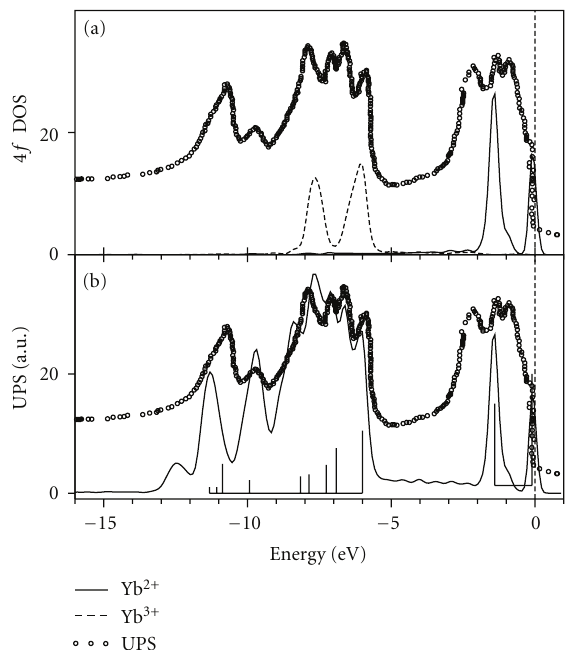
Figure 57: (a) The calculated 4 f DOS of YbB 12 for Yb 2+ and Yb 3+ configurations [349] in comparison with the experimental UPS spectra from [354]; (b) the calculated 4 f DOS of YbB 12 taking into account the multiplet structure of the 4 f 13 and 4 f 12 final states (see explanation in the text) in comparison with the experimental UPS spectra from [354].